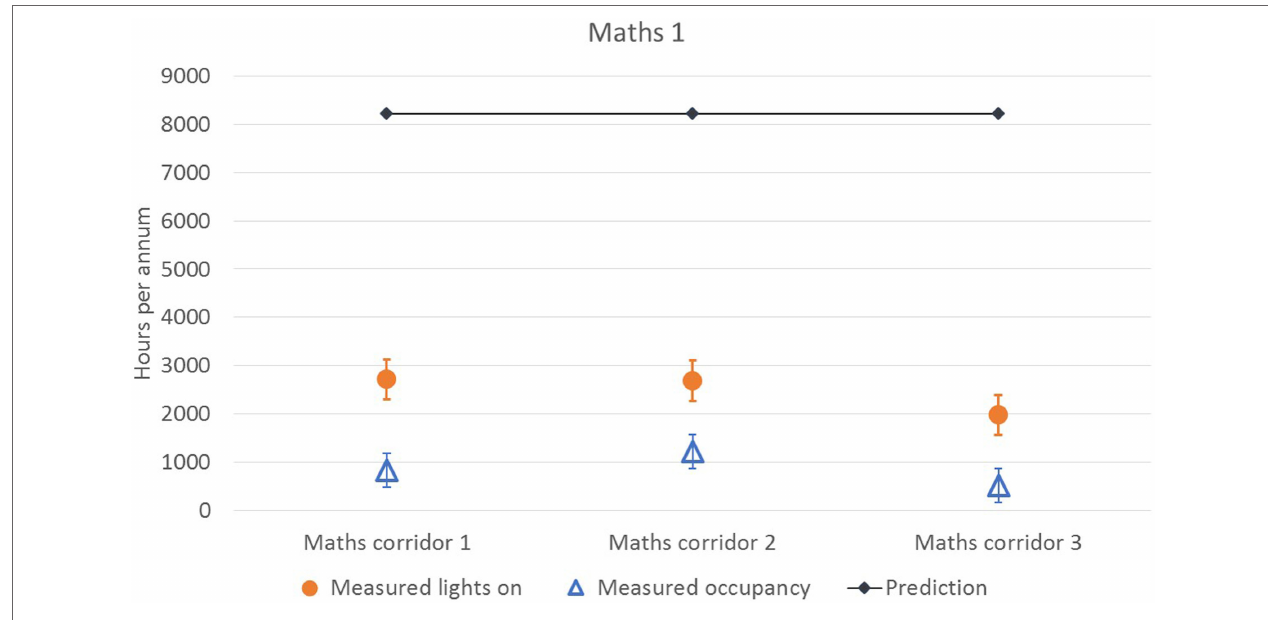
FigUre 5 | Predicted operational hours and measured hours per annum in Maths 1